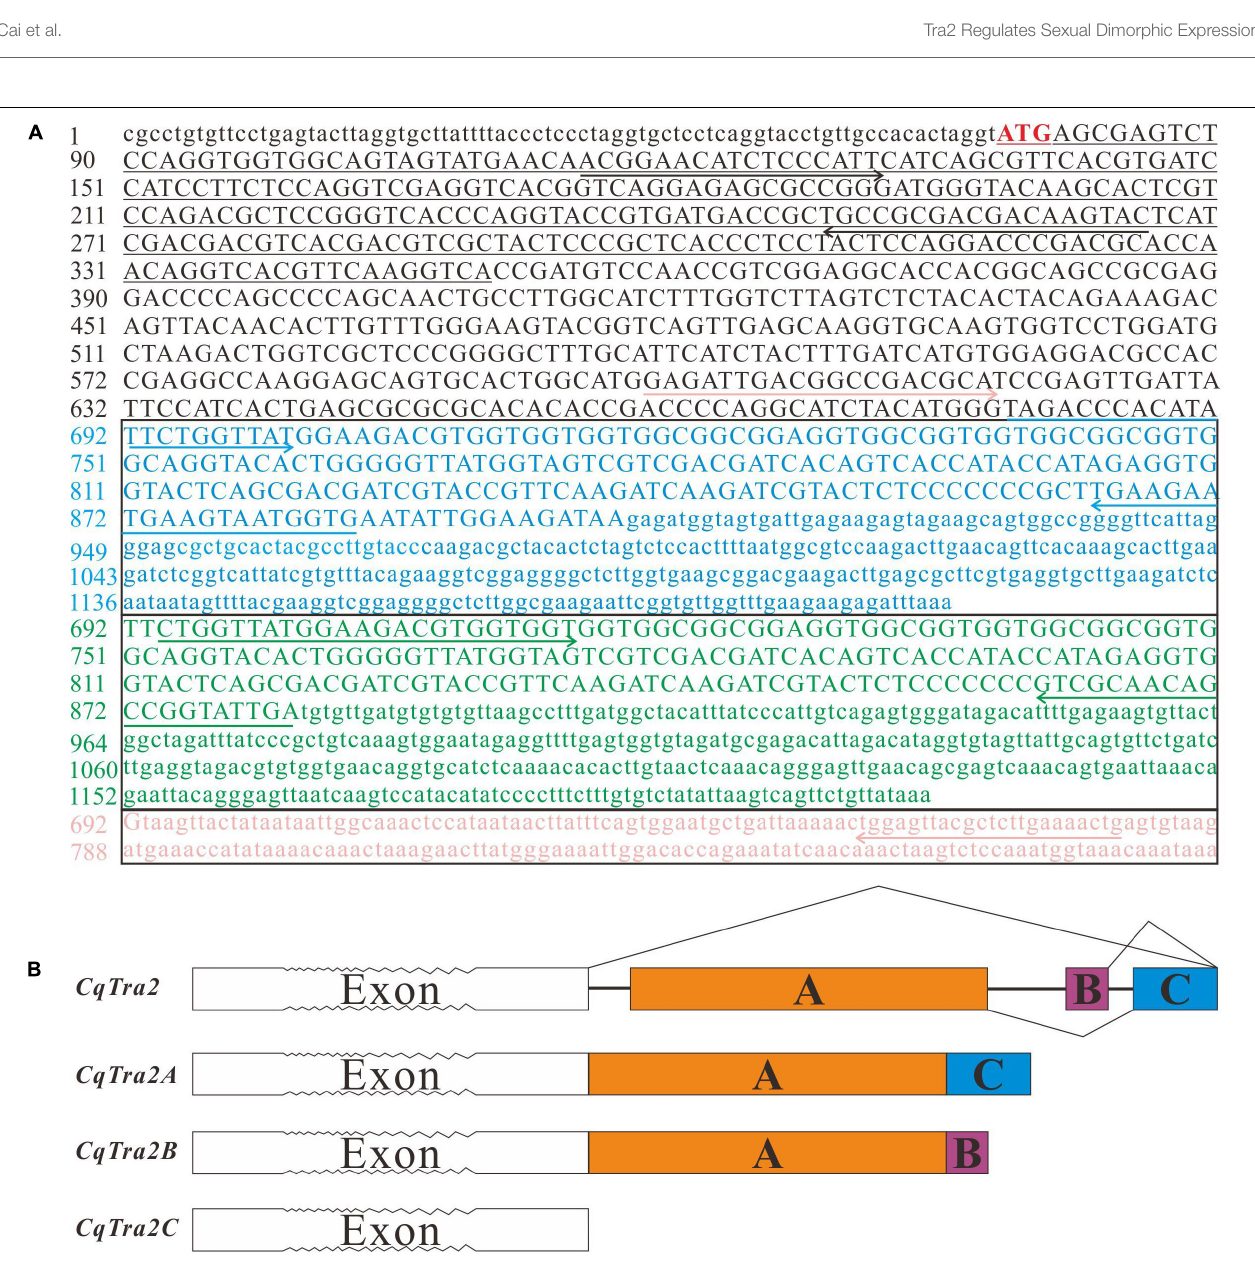
FIGURE 1 | Nucleotide sequences and schematic diagram of Tra2 homologs in C. quadricarinatus . (A) Nucleotide sequences of Tra2 homologs ( CqTra-2A , CqTra-2B , and CqTra-2C ). The start codon (ATG) is marked with a red background. The nucleotides are numbered on the left. The lower-case letters indicate 5 (cid:48) and 3 (cid:48) untranslated regions, and upper-case letters indicate the coding region. The different colors represent the specific region of the three spliced isoforms, in which blue represents CqTra-2A , green represents CqTra-2B , and orange represents CqTra-2C . The different colored solid line arrows show the primers used in RT-PCR for the three different isoforms. Underlining represents the sequence used to synthesize the dsRNA for RNAi. (B) Schematic representation of the genomic sequence of CqTra2 and pre-mRNA splicing. White boxes with serrated teeth indicate mutual exons but not exact numbers of exons. Colored boxes show the alternatively spliced exons. The solid lines show introns, the crease lines show the manner of alternative splicing of Cqtra2